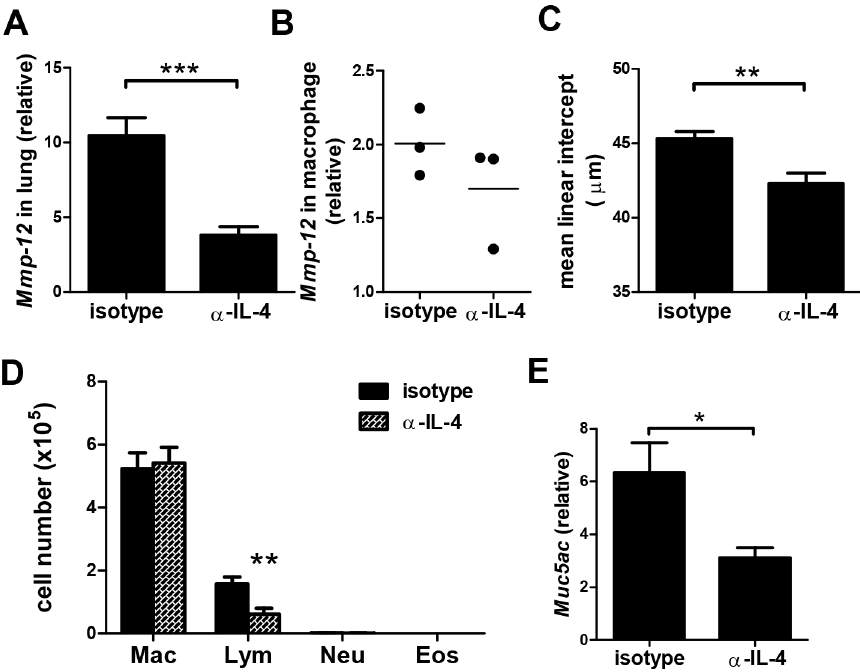
Fig 6. Anti-IL-4 Abs reduced emphysema and mucus production in mice repeatedly administered with α -GalCer. Mice were injected with neutralizing Abs to IL-4 or isotype controls 1 hour prior to each α -GalCer administration. Histopathological examination was measured 2 weeks after the last α -GalCer administration. (A) The expression of Mmp-12 in lung tissues was analyzed by quantitative RT-PCR. (B) The expression of Mmp-12 in lung macrophages was analyzed by quantitative RT-PCR. (C) The mean linear intercept of the alveolar septa was measured. (D) The absolute numbers of macrophages, neutrophils, eosinophils, and lymphocytes were measured. Mac, macrophage; Lym, lymphocyte; Neu, neutrophil; Eos, eosinophil. (E) The expression of Muc5ac in lung tissues was detected by quantitative RT-PCR. n = 9 – 16 mice for each group. * , p < 0.05; ** , p < 0.01; *** , p < 0.001 using Mann-Whitney U